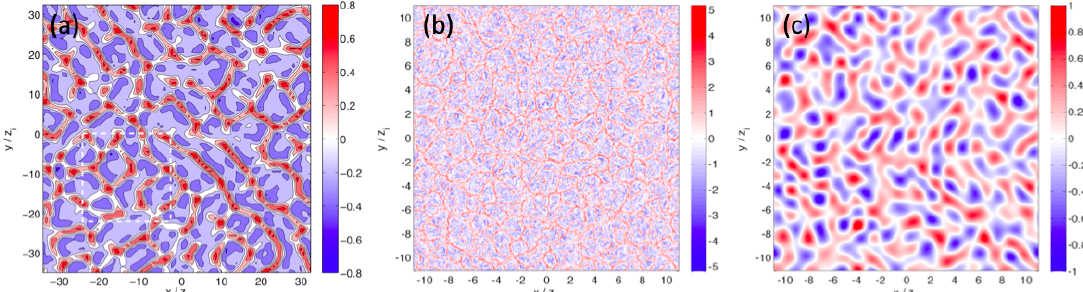
Figure 3. Horizontal distribution of vertical velocity (m/s) from: ( a ) a 1200 m run; ( b ) a 25 m run; and ( c ) the 25 m run filtered onto a 1200 m grid. The dashed line in ( a ) is the same size as the domain in ( b , c ) for comparison. Contours are from the horizontal plane at z / z i = 0.1 at 1500 LST. Note the different color bars. Adapted from Zhou et al. [13].